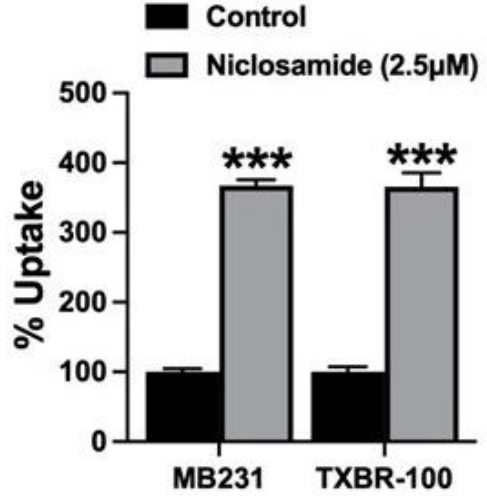
Figure 8. Effect of preexposure of MB231 cells to niclosamide on SLC38A5-mediated uptake. The cells were preexposed to niclosamide (2.5 μ M) for 30 min in a NaCl-buffer. DMSO was used for control. Following the preexposure, cells were washed thrice with the same NaCl-buffer, but without niclosamide or DMSO. Serine uptake (0.4 μ M) was then initiated in two different buffers (NMDGCl-buffer and LiCl-buffer), both at pH 8.5 and both containing 5 mM tryptophan. Niclosamide was not present during uptake. Data (means ± S.E.M) are given as percent of control (i.e., SLC38A5-specific serine uptake in cells preexposed only to DMSO). ***, p < 0.001.